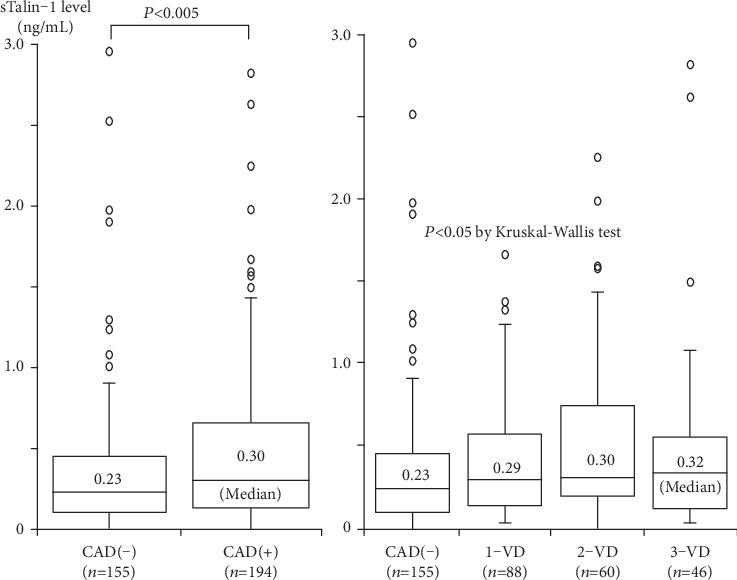
Plasma sTalin-1 levels and the presence of CAD or the number of stenotic coronary vessels. Plasma sTalin-1 levels were significantly higher in CAD than in CAD(-) (left). Moreover, sTalin-1 levels in 4 groups of CAD(-), 1-VD, 2-VD, and 3-VD were 0.23, 0.29, 0.30, and 0.32 ng/mL, respectively, and were highest in 3-VD (P < 0.05 by Kruskal-Wallis test) (right). The central line represents the median, and the box represents the 25th to 75th percentiles. The whiskers represent the lowest and highest value in the 25th percentile minus 1.5 IQR and 75th percentile plus 1.5 IQR, respectively.